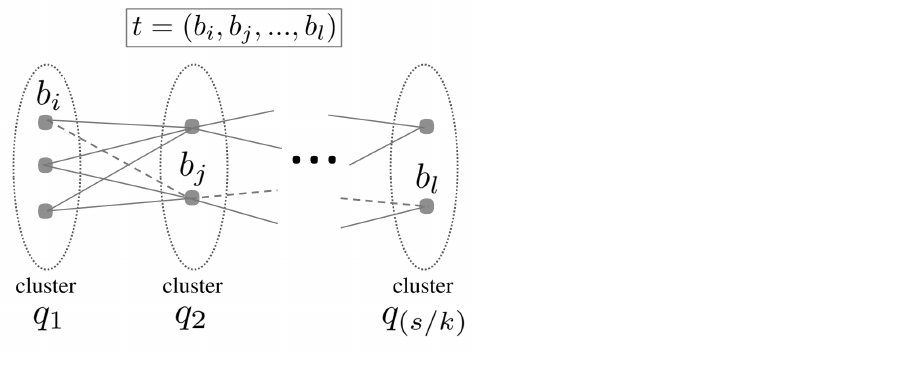
Figure 3. Each cluster provides one band for the composition of tuple t . In this example, the band b i ∈ q 1 , the band b j ∈ q 2 , and the band b l ∈ q s / k , among others connected by the dashed line, form the tuple t . Each possible combination of bands in different clusters gives rise to all t ∈ Q